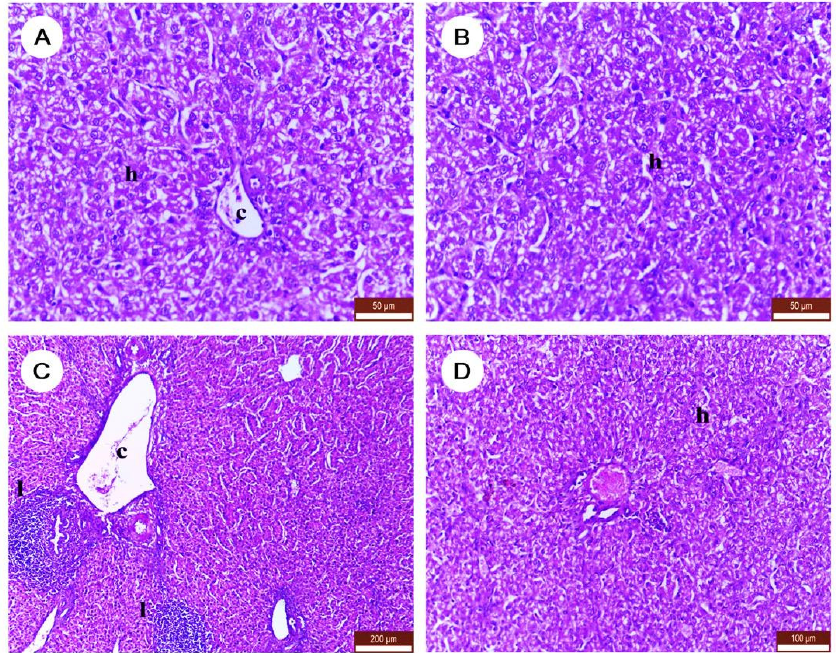
Figure 5. Changes in the liver histopathology after treatment with DLM and/or NAC. ( A ) Control group (scale bar = 50 µm), ( B ) NAC group (scale bar = 50 µm), ( C ) DLM (scale bar = 200 µm); and group (scale bar = 50 µ m), ( B ) NAC group (scale bar = 50 µ m), ( C ) DLM (scale bar = 200 µ m); ( D ) DM+NAC (scale bar = 100 µm). c: Central vein, h: hepatic lobules, l: inflammatory cells infiltra- and ( D ) DM+NAC (scale bar = 100 µ m). c: Central vein, h: hepatic lobules, l: inflammatory cells tion. (H&E stain). infiltration. (H&E